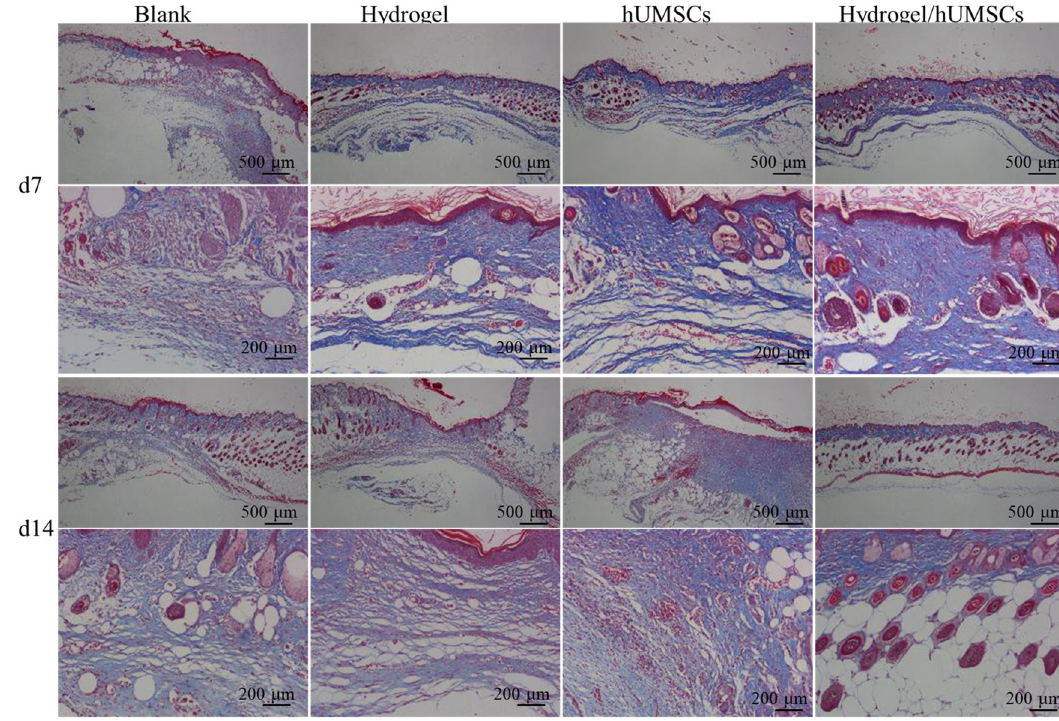
Fig. 8 Masson ’ s trichrome staining of wound sections at day 7 or 14 post-wounding for four